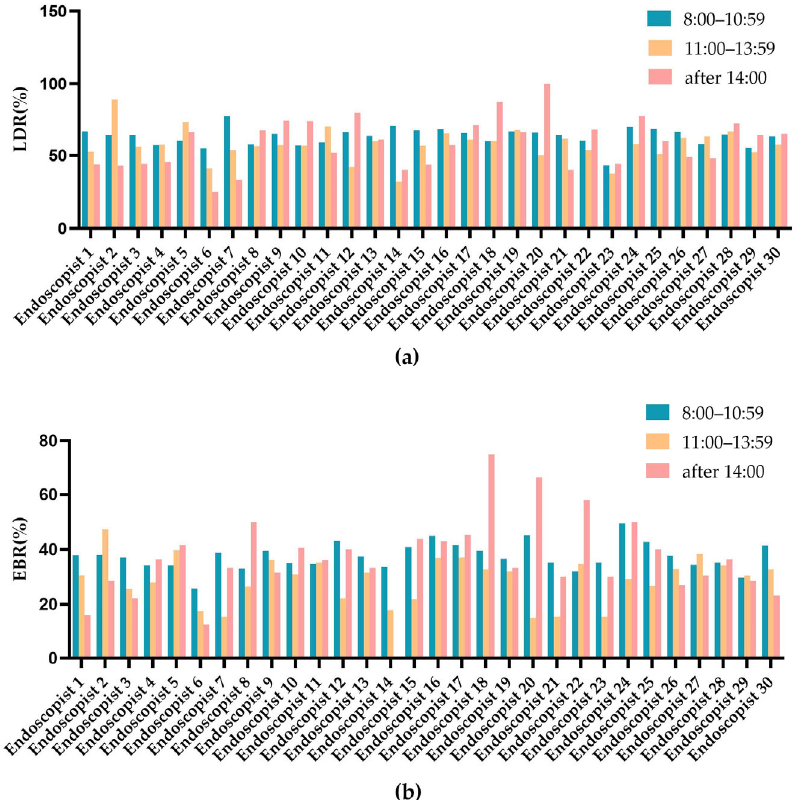
Figure 3. Comparison of individual endoscopist’s LDR and EBR in three shifts. ( a ) The comparison of individual endoscopist’ LDR; ( b ) The comparison of individual endoscopist’ EBR. LDR, lesion detection rate; EBR, endoscopy biopsy rate.